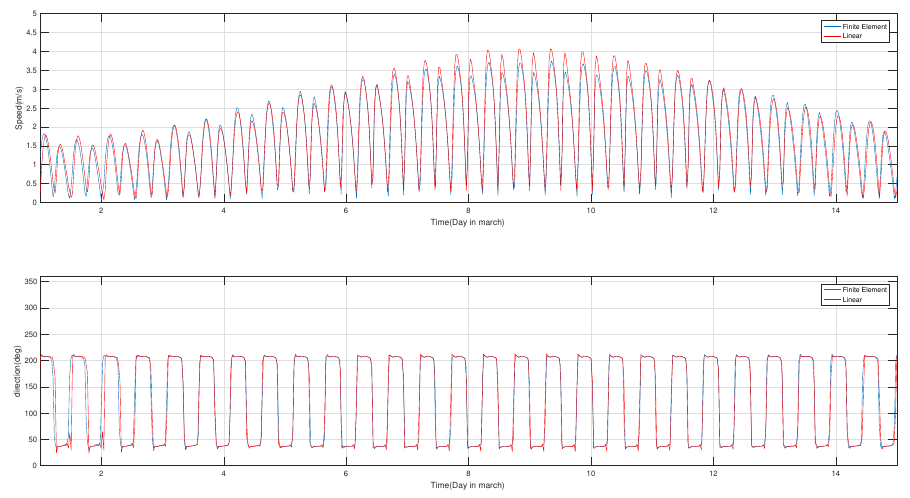
Figure 5. Time series of the predicted depth-averaged amplitude and direction (anticlockwise convention from the east) of the current at point #2 in neap-spring tidal